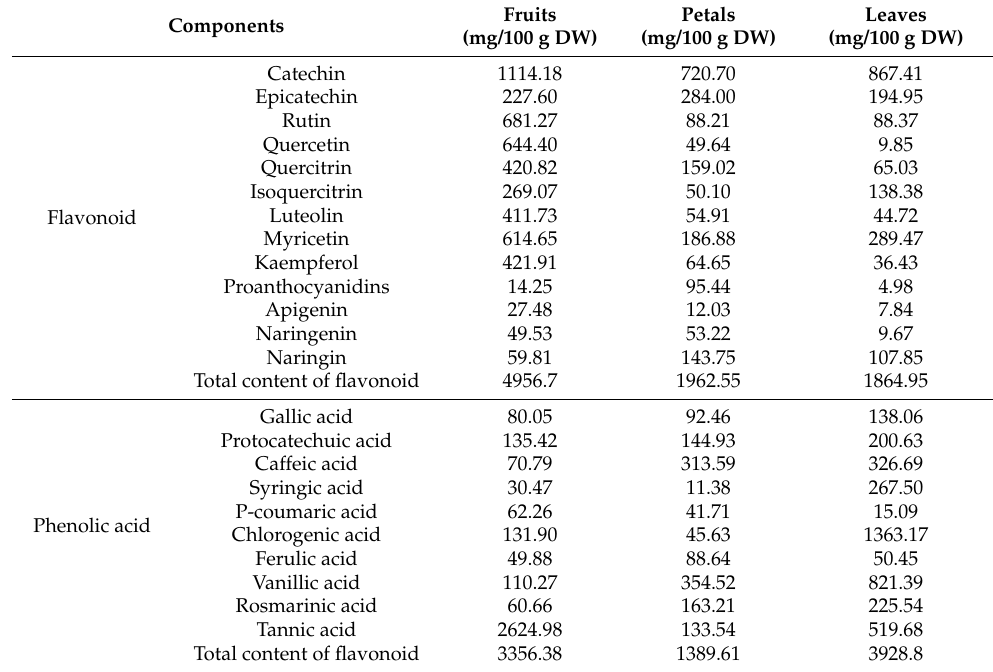
Table 4. Components of flavonoid and phenolic acid in fruits, petals, and leaves of R. roxburghii